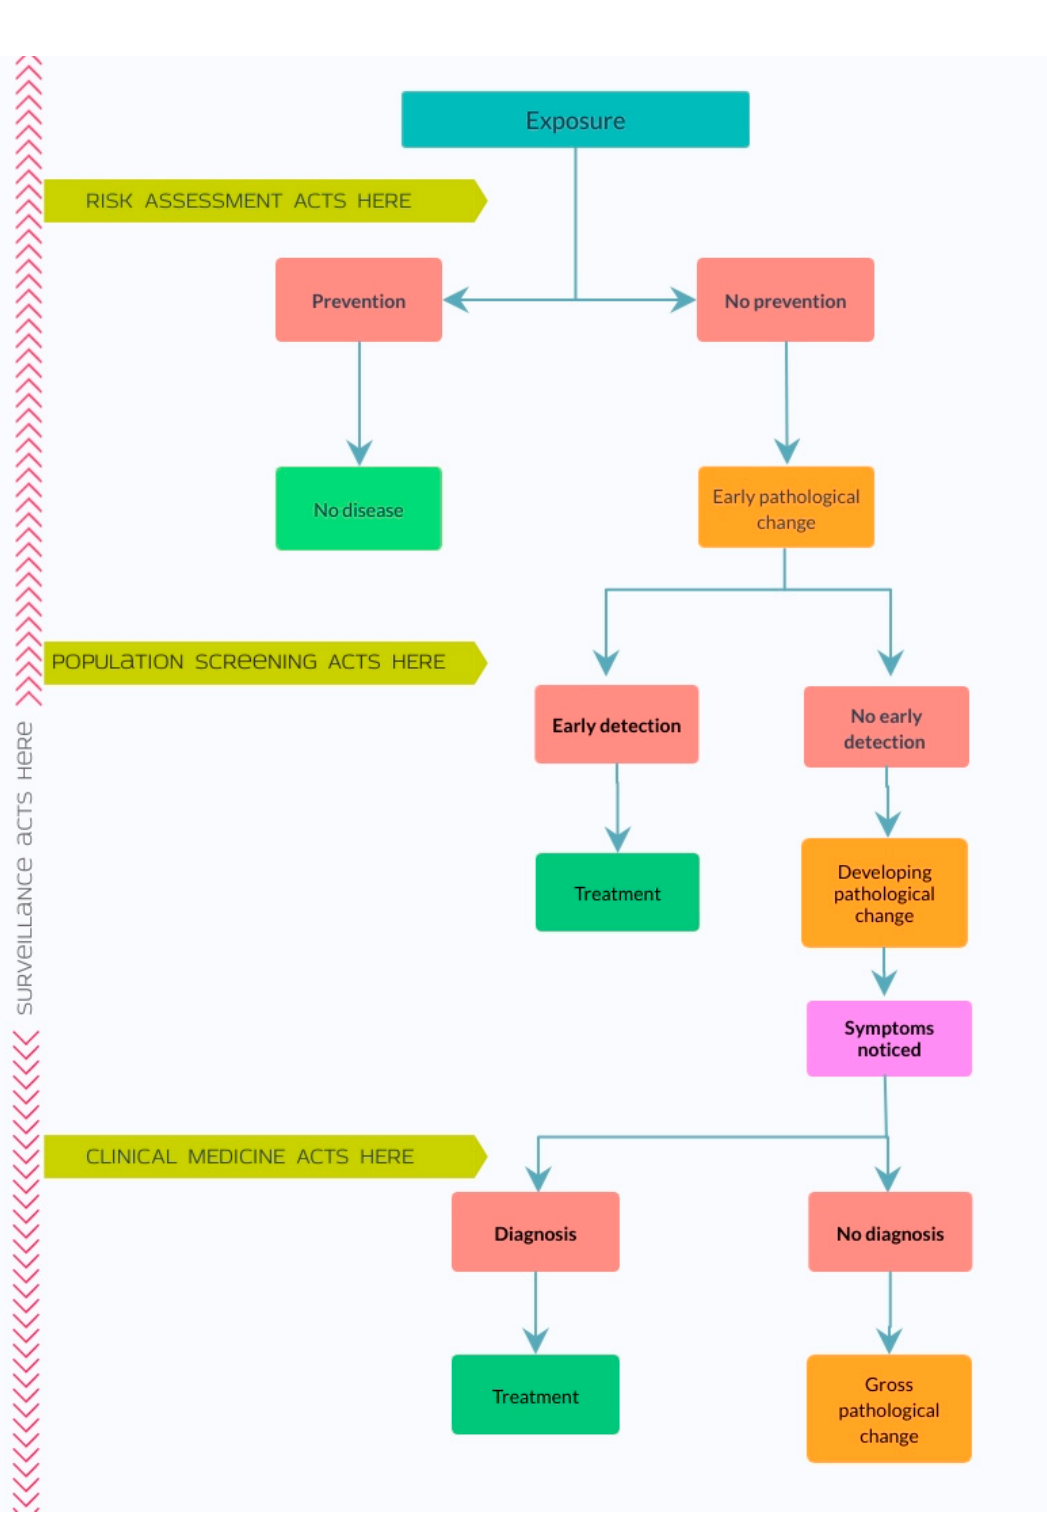
Figure 1. Case finding and disease progression after environmental exposure. Developed from [17].